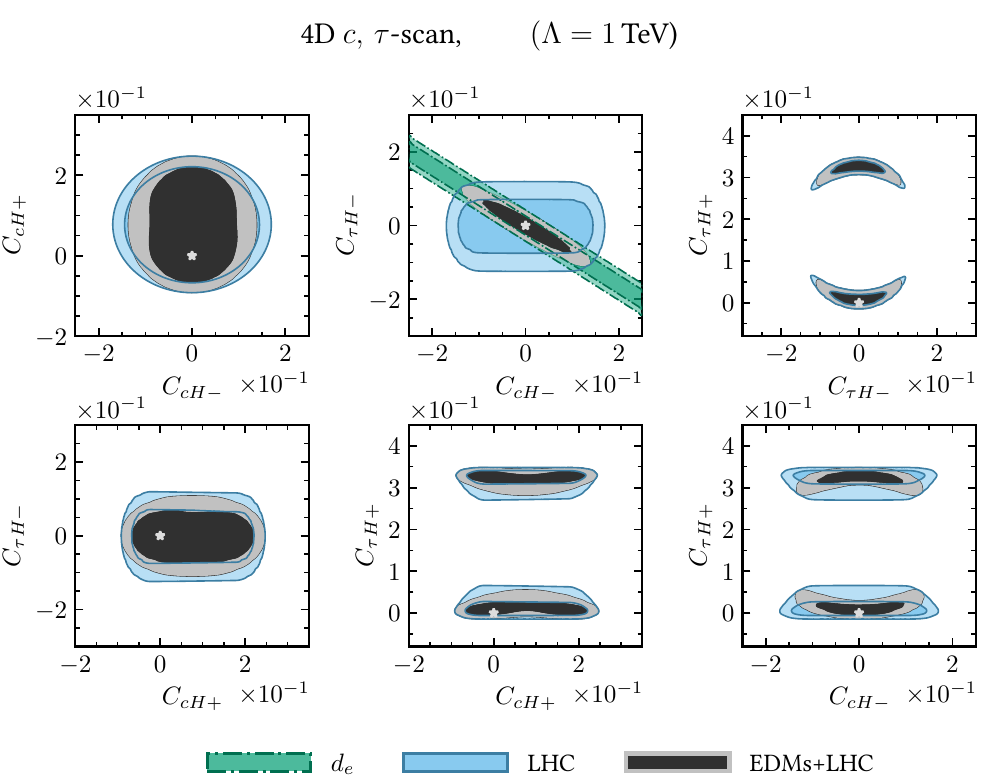
Figure 9 . Constraints resulting from a 4D scan of charm and τ Wilson coefficients ( C cH ± , C τH ± ) assuming Λ = 1 TeV. In each plot only two parameters are shown, the remaining two are profiled over (see main text). Contours represent the allowed 68% and 95% confidence regions, the colour coding of individual constraints is given in the legend, and grey/black areas correspond to the combined regions. For details see main text and the caption of figure